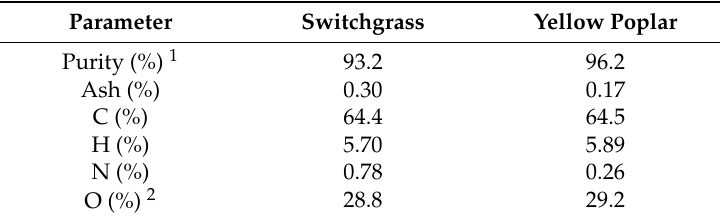
Table 1. The composition of switchgrass and yellow poplar lignin samples. Parameter Switchgrass